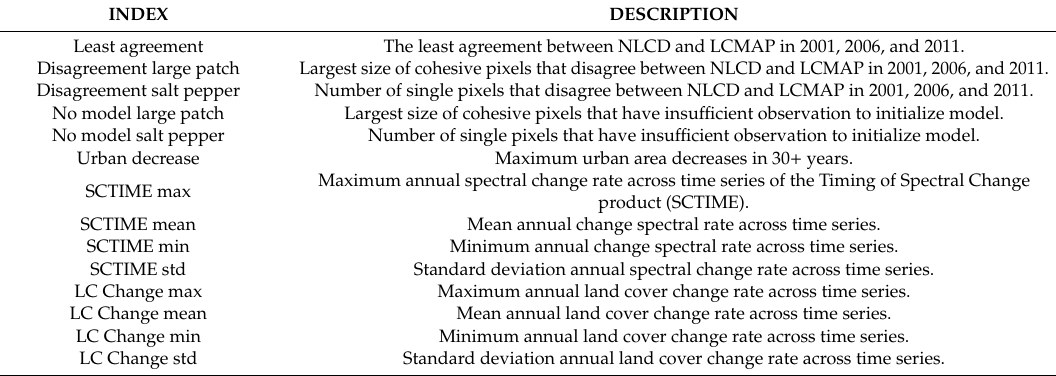
Table 2. List of indices for each tile to characterize the reasonableness of LCMAP products in both spatial and temporal